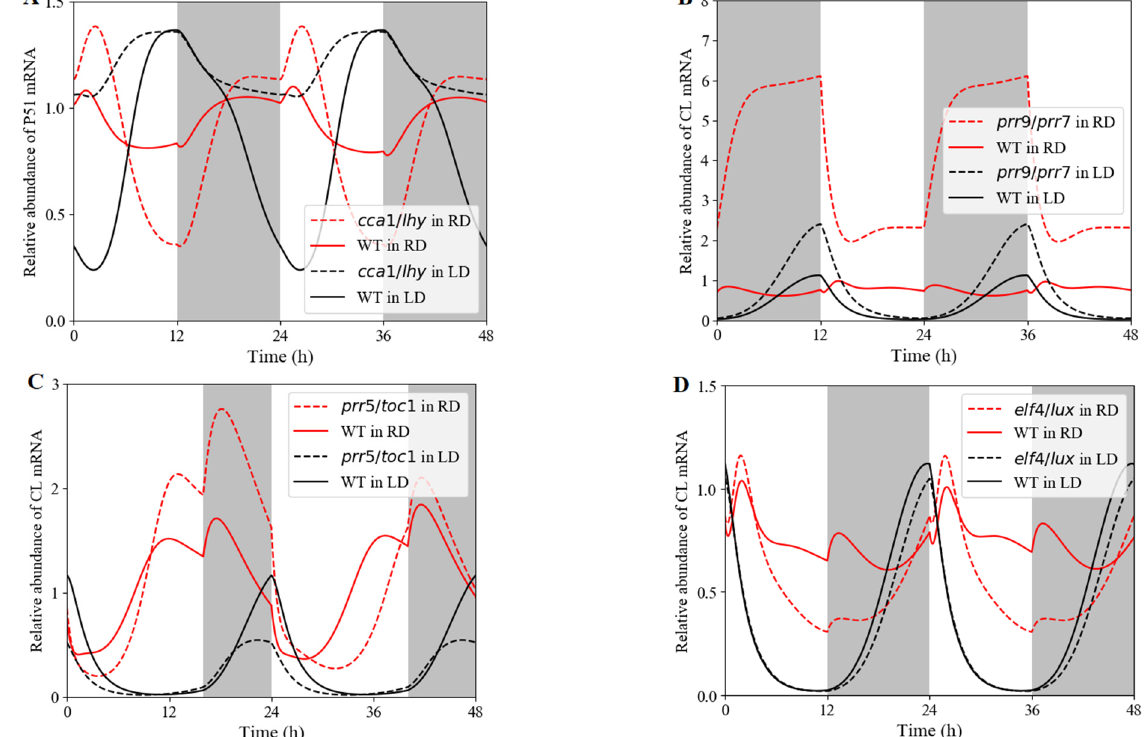
Figure 7. Expression of clock genes in loss-of-function mutants under either white-light/dark or red-light/dark cycles. Simulated mRNA levels in various clock mutants (dashed lines) and their respective wild types (solid lines) under red-light cycles (RD, red lines) and white-light cycles (LD, black lines). ( A ) Simulated PRR5/TOC1 expression in the cca1/LHY double mutant. ( B ) CCA1/LHY expression in the prr9/prr7 single mutant. ( C ) Simulated CCA1/LHY expression in the prr5 / toc1 single mutant. ( D ) Simulated CCA1/LHY expression in the elf4/lux single mutant. The grey and white bars represent darkness and light (white light (L) or red light (R)) treatments, respectively.